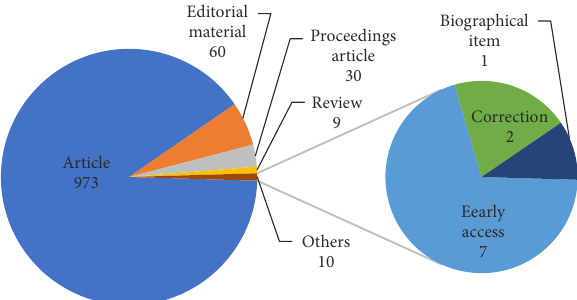
Figure 1. The type distribution of publications in the CACAIE